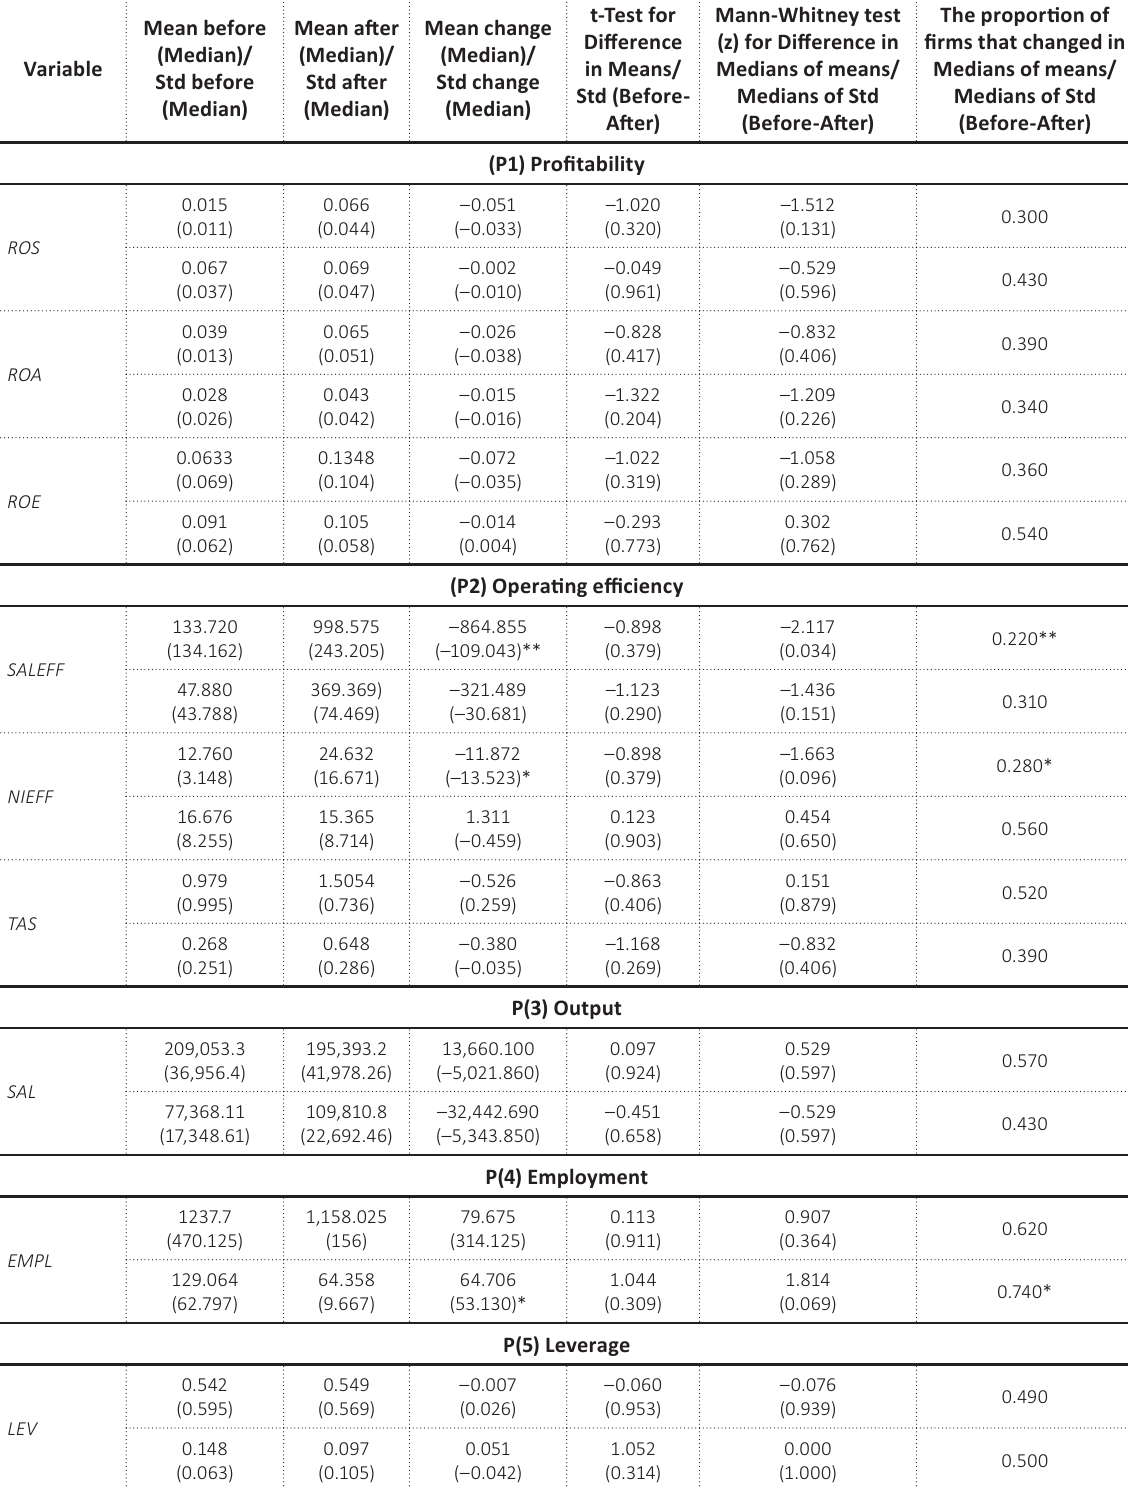
Table A1. Performance changes of privatized SOEs in agriculture, fishing and aquaculture and mining sectors (privatized SOEs with tax incentives)